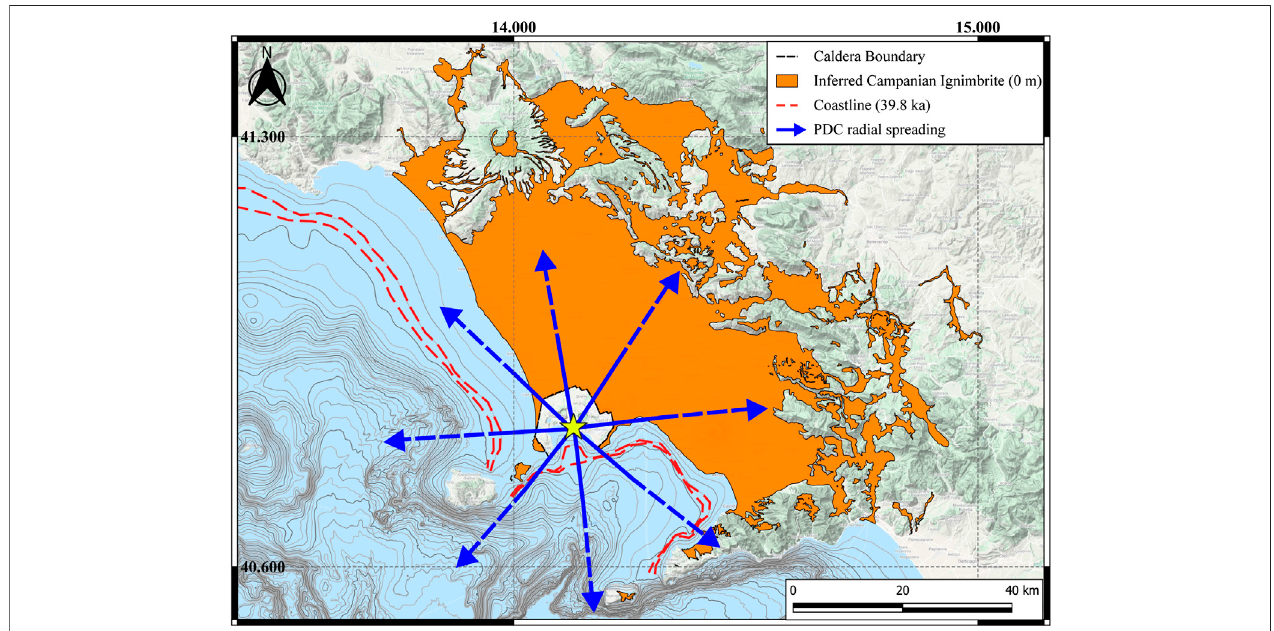
FIGURE8| Bathymetry ofthesubmerged areaoftheCampiFlegrei caldera.The redlineisthe40 ka coastline, equivalent to − 75to − 87 mofthepresent one. The bluearrowsindicatethepossibleradialspreadingofthepyroclasticdensitycurrent(PDC)basedonoutcropsdisposedradiallyfromthecenterofthecaldera(yellowstar) and turbidity currents in the Tyrrhenian Sea. Accumulation of volume south of the caldera is credible, due to the large submarine depressions and valleys.